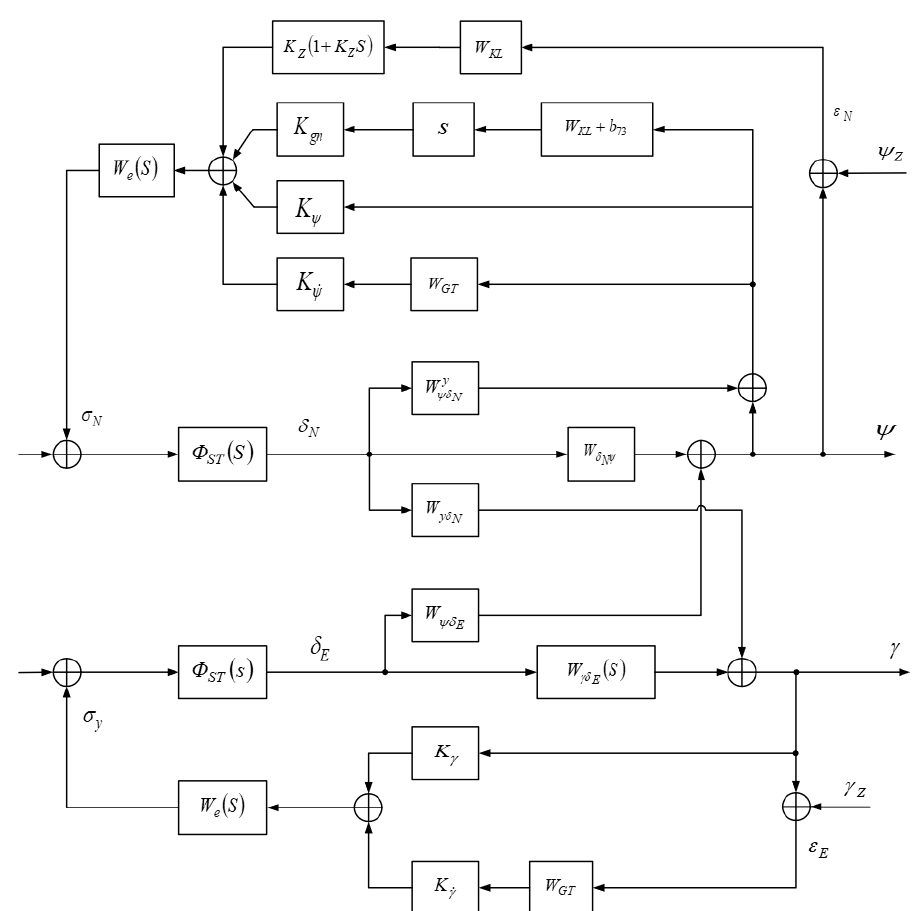
Figure 4. Block diagram of a continuous two-dimensional lateral stabilization system taking into account the elastic connections of the object (“model 2”).